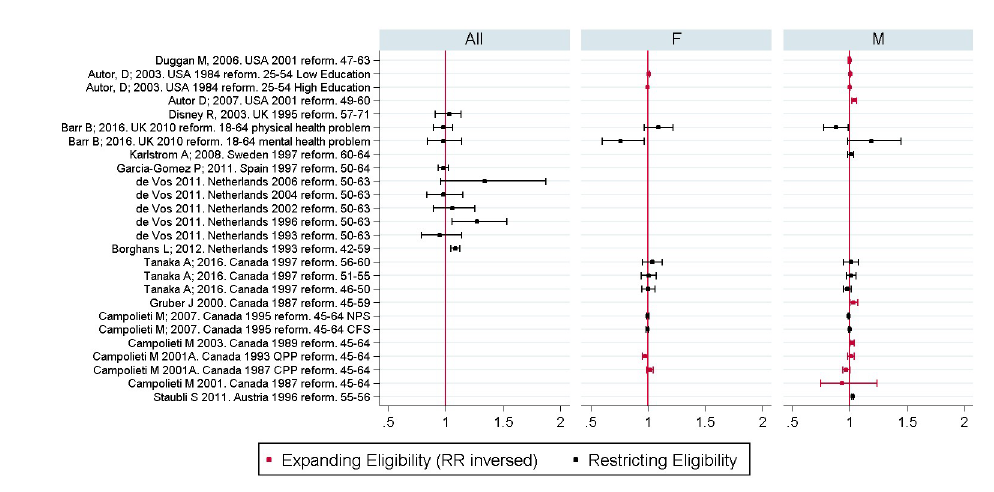
Fig 3. Forest plot showing the relative effect of restricting eligibility to disability benefits on employment, by age group by sex. Note: Colum labels show, author, publication year, year of policy reform, age group. For Barr (2016) [21] separate results are given for people with mental and physical health problems, for Autor (2003) [9] separate results are given for high and low educated groups, for Campolieti (2007) [26] separate results are also given for analysis using National Population Health Survey (NPS) and Survey of Consumer Finances